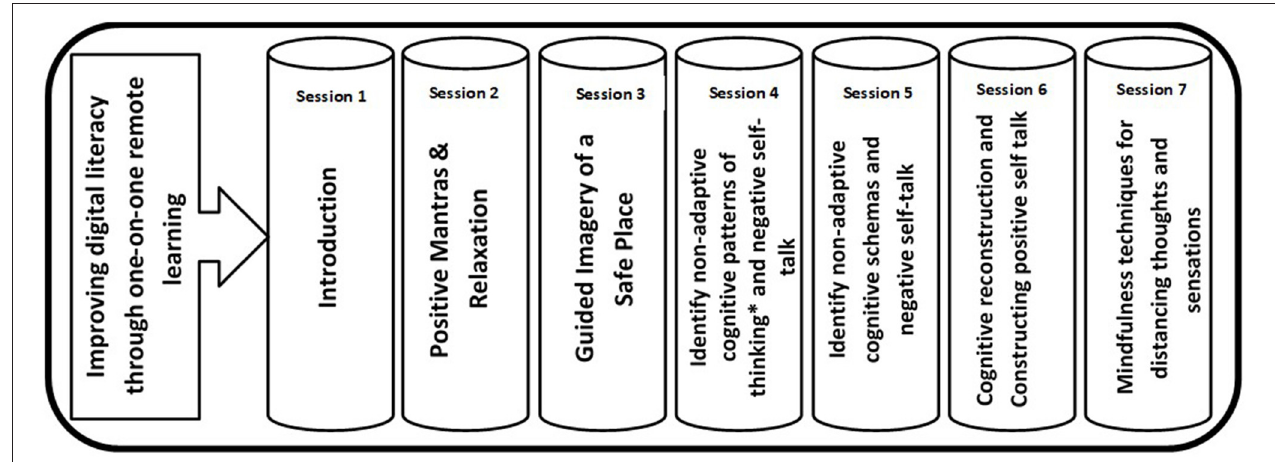
FIGURE 1 | Skills and techniques addressed by the digital group intervention. Sessions are held via Zoom. Whatsapp is used to send participants supplementary materials such as voice recordings of relaxation, meditation, and guided imagery of a safe place to assist in self-practice. *Based on the work of Albert Ellis (43).